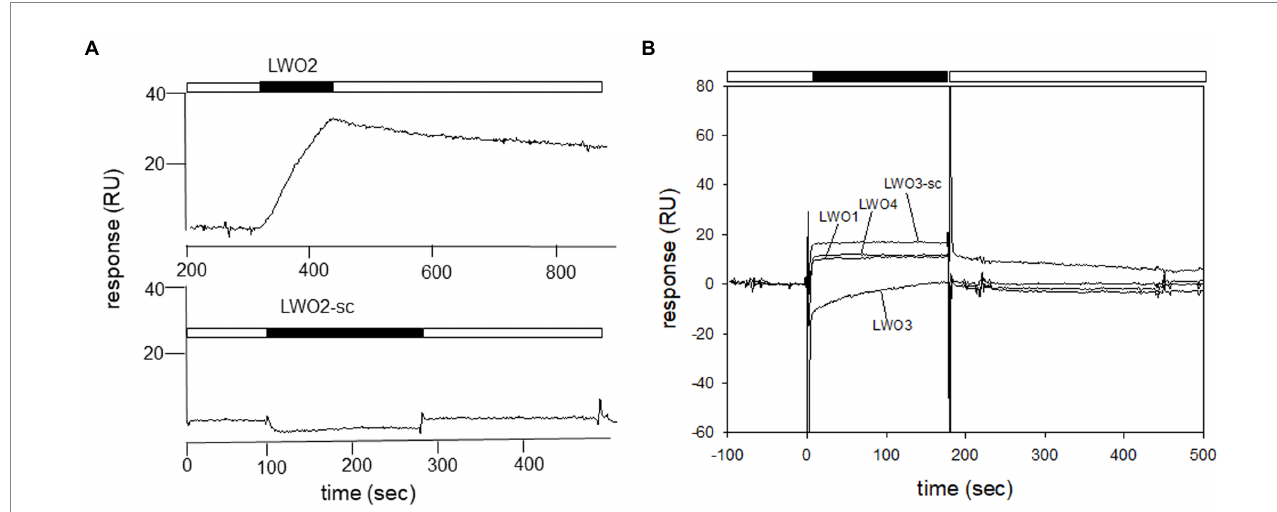
FIGURE 2 Identification of Gt α /Gi α interacting cytoplasmic loops by SPR. Purified Gt α /Gi α was immobilized on a CM5 sensor chip via amine coupling. Peptides were dissolved in SPR running buffer and flushed over the surface at a concentration of 100 nM. (A) Comparison of sensorgrams recorded with LWO2 and the control peptide LWO2-sc. The sensorgram of the LWO2 experiment (upper trace) starts at 200 s, because the recording had a longer buffer run before injection than the experiment with LWO2-sc (lower trace) and we cut the prerun containing no information. The black bars indicate the injection of the peptides, white bars show flowing of running buffer. When the injection of the peptide stops, the flow of running buffer triggers the dissociation of the LWO2-Gt α /Gi α complex. (B) Sensorgrams displaying the injection of peptides LWO1, LWO3, LWO4, and LWO3-sc. Black and white bars as in (A)